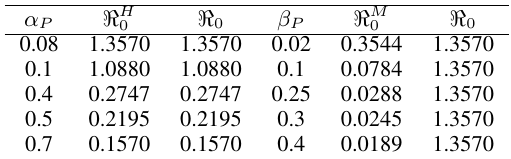
Table III: Values of the basic reproduction numbers for the parameter values α P and β P .